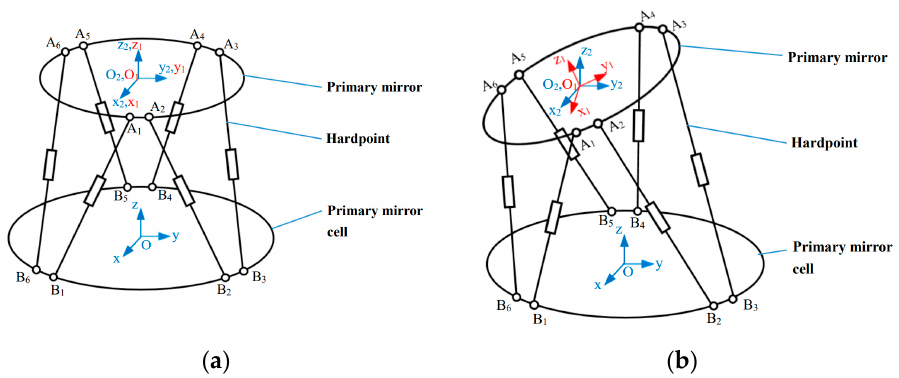
Figure 2. Structural diagram of the six-hardpoint positioning mechanism. ( a ) The mechanism in the initial pose; ( b ) The mechanism in the state after a pose adjustment.